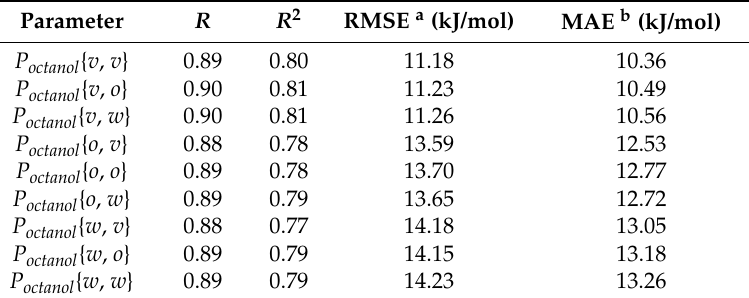
Table 2. Summary of free energy in octanol calculations.